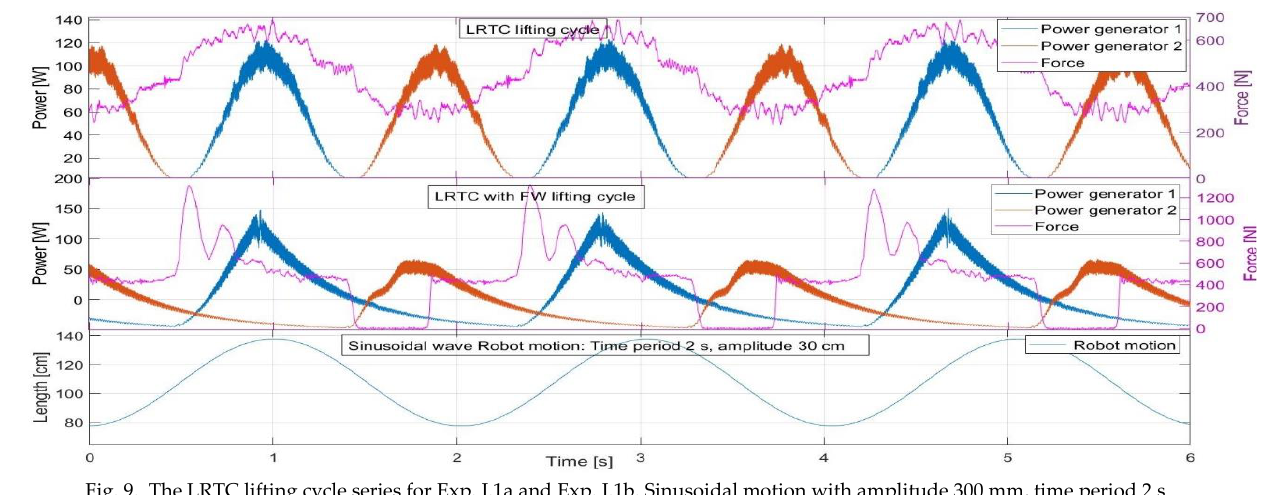
Fig. 9. The LRTC lifting cycle series for Exp. I.1a and Exp. I.1b. Sinusoidal motion with amplitude 300 mm, time period 2